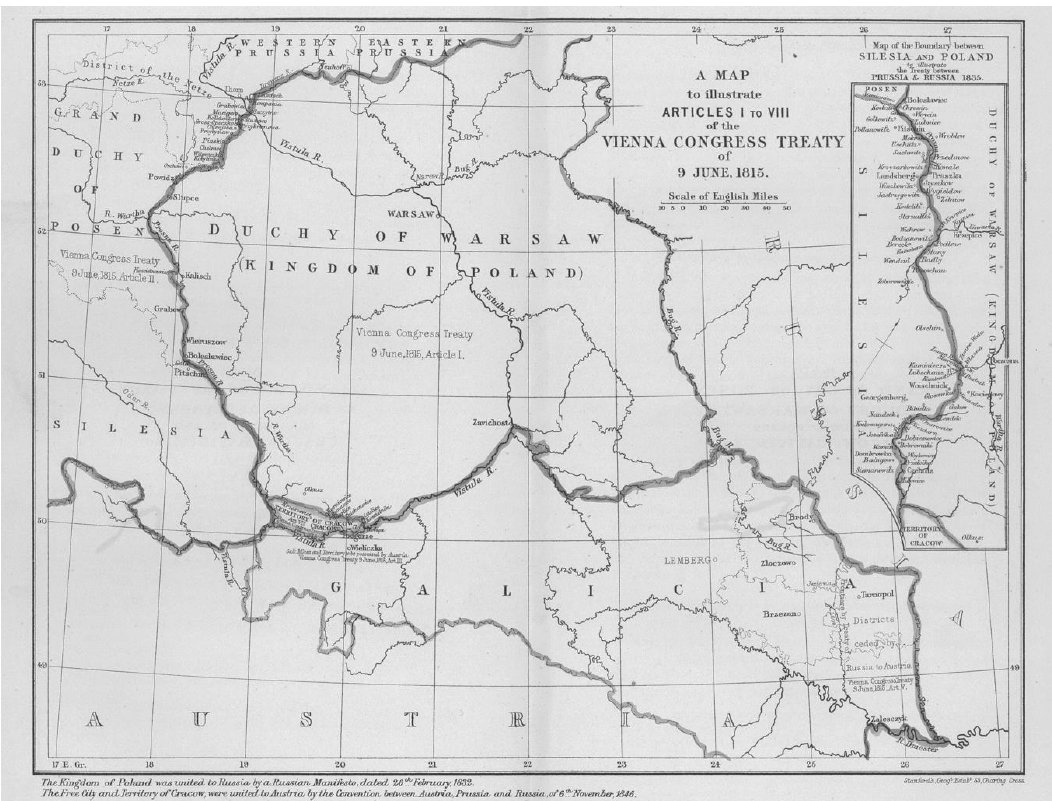
ISPRS Int. J. Geo-Inf. 2019 , 8 FOR PEER REVIEW Figure 5. The Division of Poland by the Congress of Vienna, from Hertslet (1875, 1891).